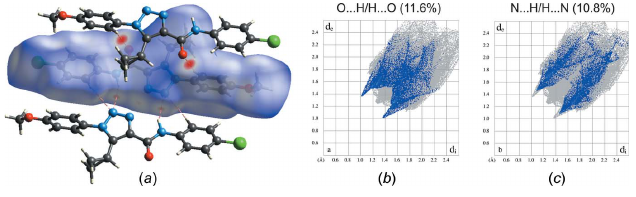
Figure 4 ( a ) Hirshfeld surface for the title molecule mapped with d norm over the range (cid:4) 0.171 to 1.473 a.u. showing N—H (cid:2)(cid:2)(cid:2) N, C—H (cid:2)(cid:2)(cid:2) N and C—H (cid:2)(cid:2)(cid:2) O hydrogen-bonded contacts. Fingerprint plots resolved into ( b ) N (cid:2)(cid:2)(cid:2) H/ H (cid:2)(cid:2)(cid:2) N and ( c ) O (cid:2)(cid:2)(cid:2) H/H (cid:2)(cid:2)(cid:2) O contacts. Neighbouring molecules asso- ciated with close contacts are also shown.